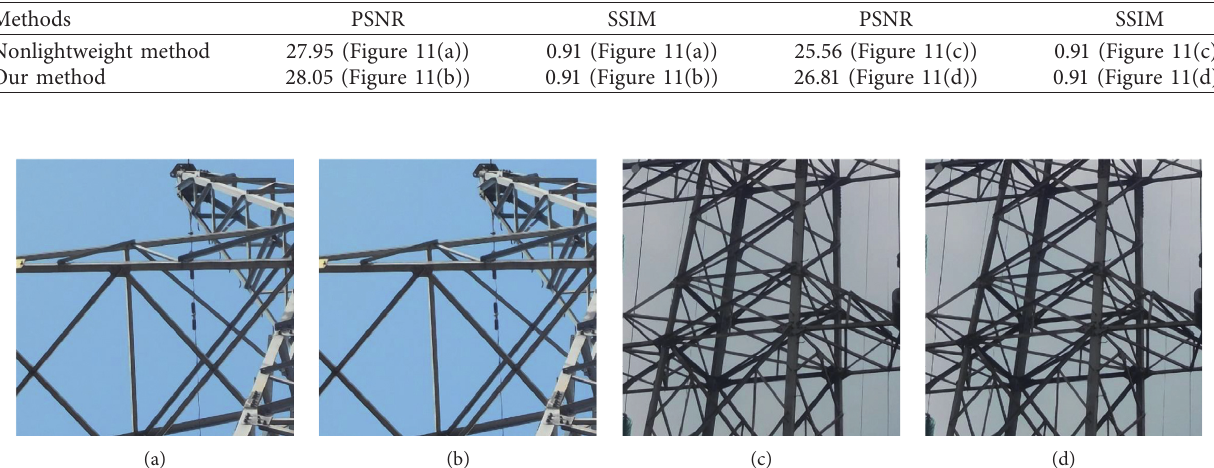
Table 2: Performance analysis of super-resolution reconstruction results by the lightweight method.